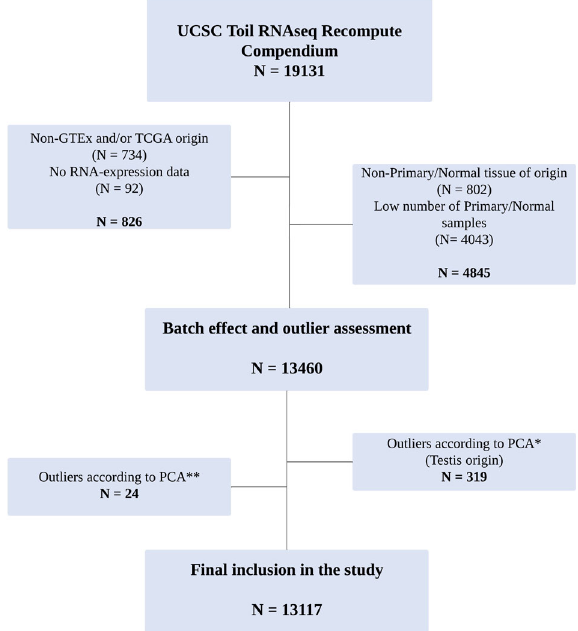
Fig. 1 CONSORT diagram of sample fi ltering and selection. *Excluded samples as shown in Supplementary Fig. 1a, b; **excluded samples as shown in Supplementary Fig. 1c,